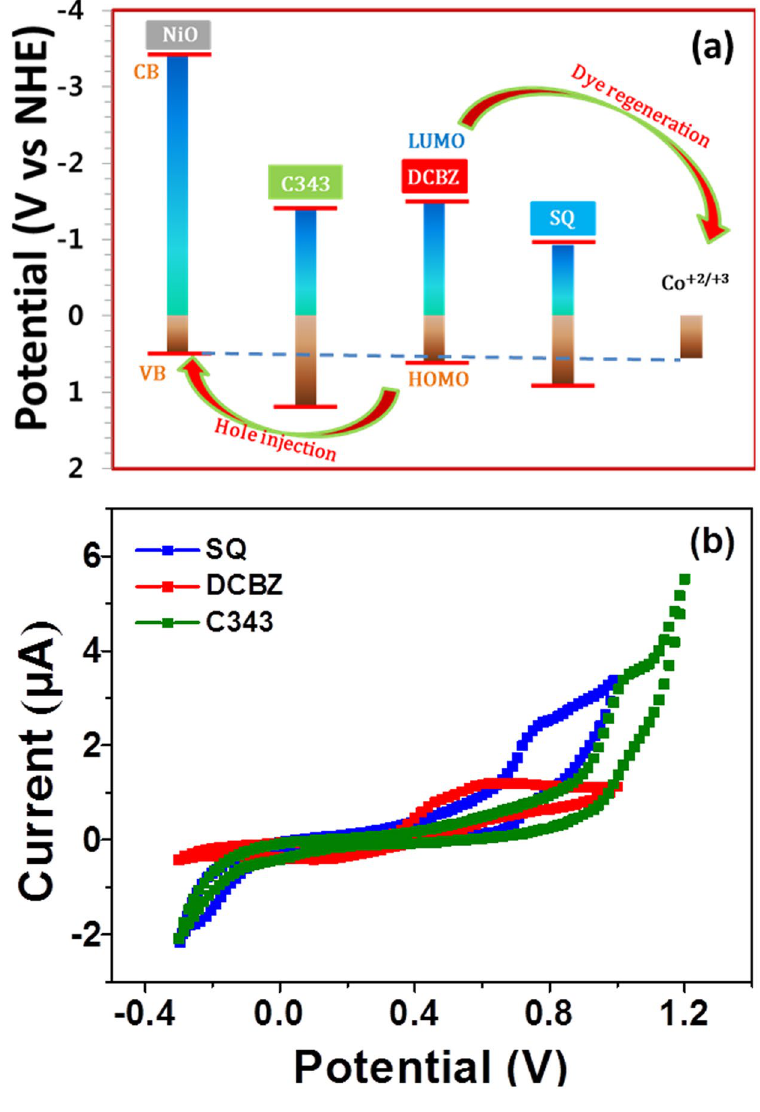
Figure 5. Energy levels and Cyclic Voltammograms. ( a ) Energy level diagram of each component in p-type photovoltaic device and ( b ) cyclic voltammograms of C343, DCBZ, and SQ obtained at a scan rate 100 mV s − 1